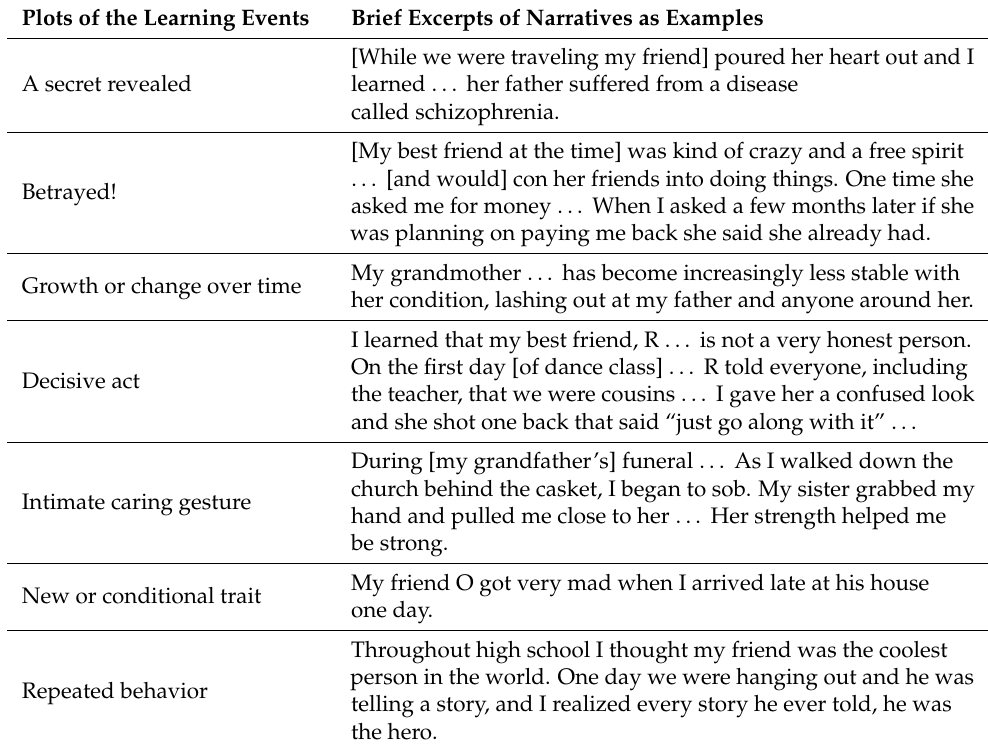
Table 4. Examples of Plots from Study 2 As Identified by Participants. Plots of the Learning